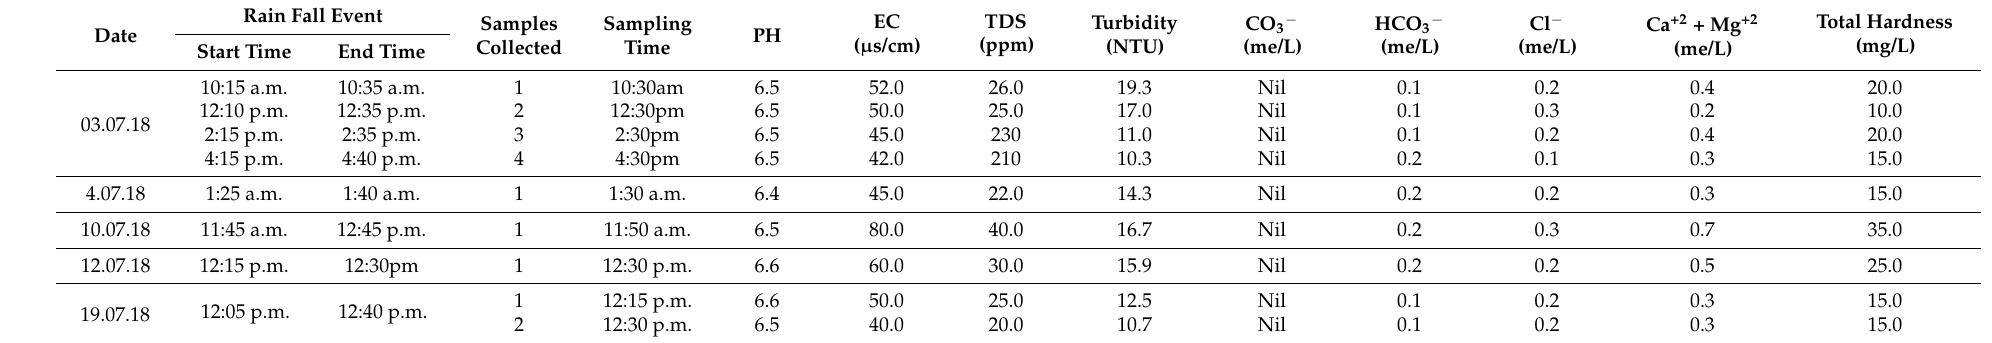
Table A6. Direct rain samples collected from Site 2.